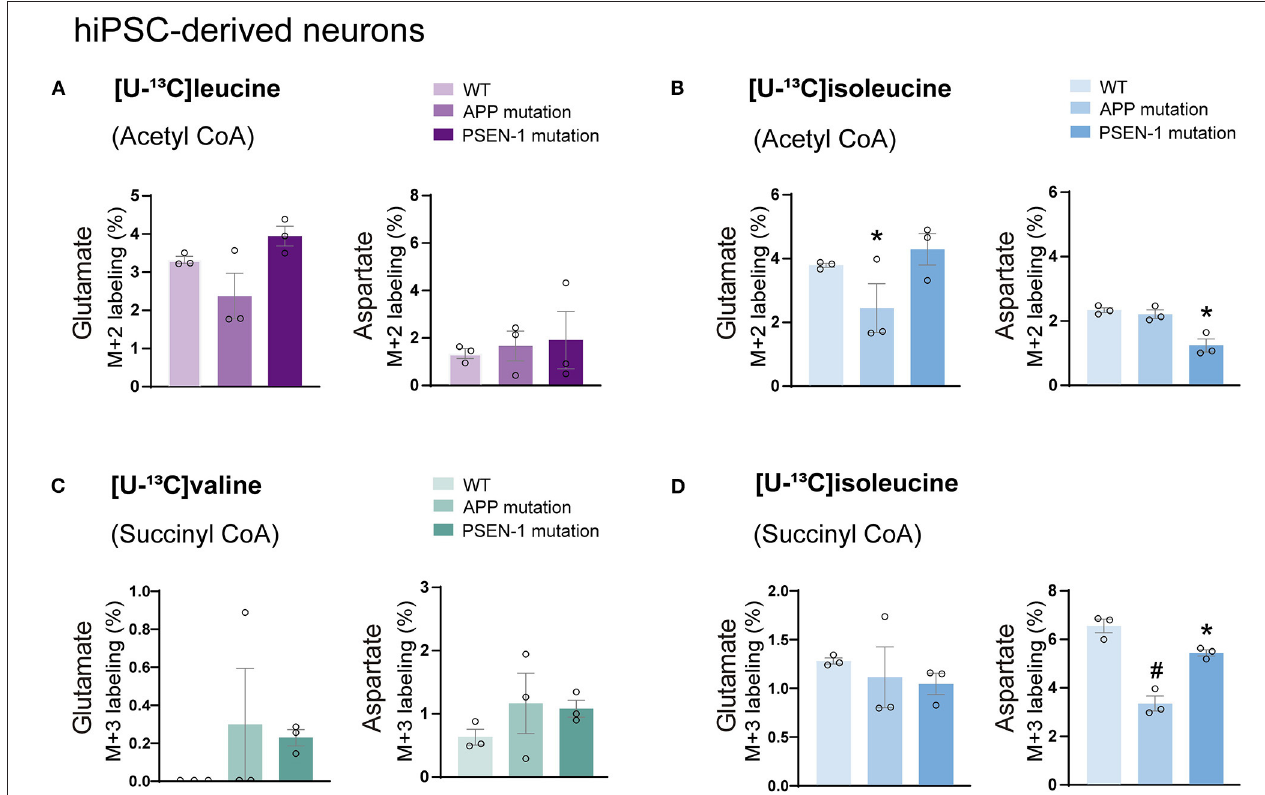
FIGURE 6 | Decreased aspartate synthesis from oxidative isoleucine metabolism in AD neurons. (A) No significant differences were found in AD neurons after incubation with [U- 13 C]leucine. (B) Decreased glutamate M + 2 and aspartate M + 2 labeling after incubation with [U- 13 C]isoleucine in AD neurons. (C) No significant differences were found in AD neurons after incubation with [U- 13 C]valine in AD neurons. (D) Decreased aspartate M + 3 labeling after incubation with [U- 13 C]isoleucine in AD neurons when compared with control. No significant differences were found in TCA cycle intermediates. Values represent mean ( ± ) SEM ( n = 3), * p < 0.05, # p < 0.0001 analyzed by two-way ANOVA. WT, wild type; APP, amyloid precursor protein; PSEN-1,